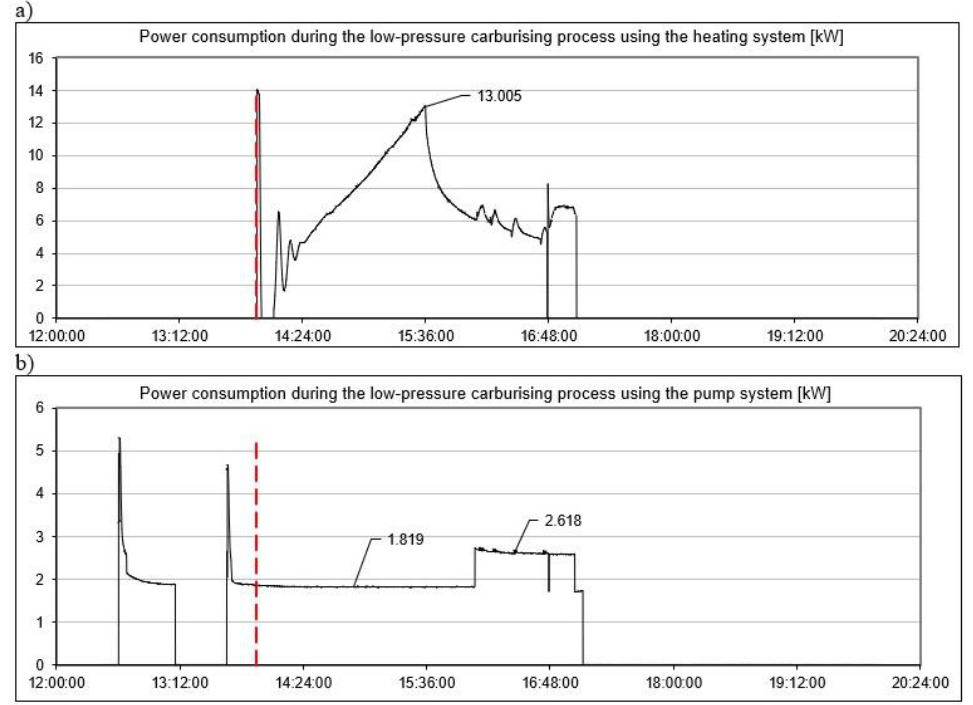
Figure 3. Power consumption during the low-pressure carburising process using the heating system ( a ) and pump system ( b ). Table 1. Results of the research